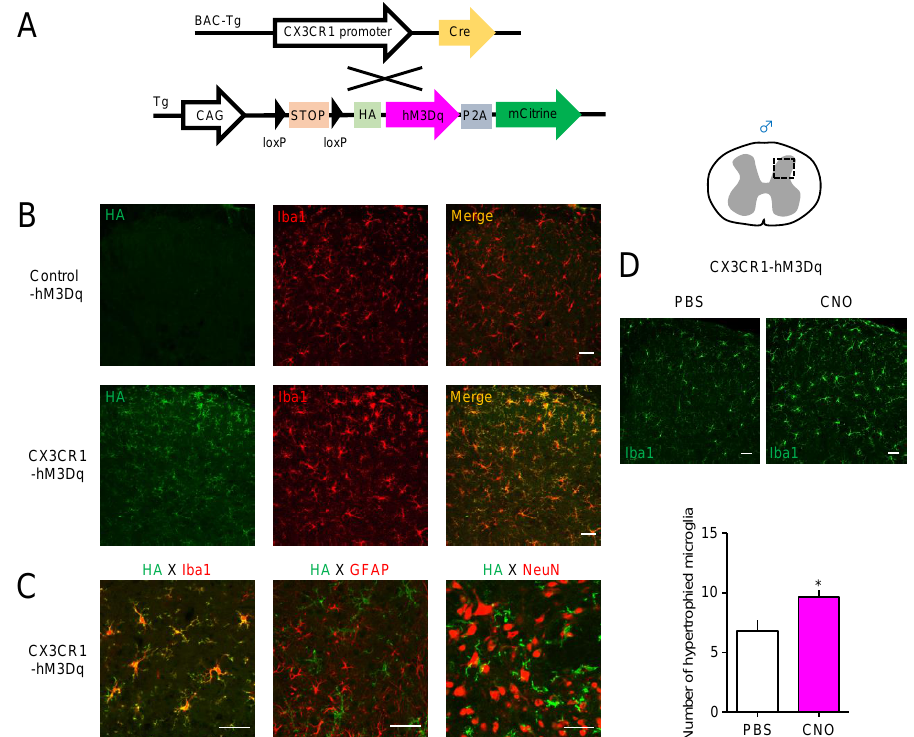
Figure 1. Activation of spinal microglia by clozapine-N-oxide (CNO) in male CX3C chemokine receptor 1, human Gq-coupled M3 muscarinic receptors (CX3CR1-hM3Dq) mice. ( A ) Scheme of Cre- dependent expression of hM3Dq in CX3CR1-expressing (CX3CR1 + ) cells by crossing CX3CR1-Cre (Tg) mice with CAG-LSL-Gq-designer receptors exclusively activated by designer drugs (Gq-DREADD) mice (Control-hM3Dq). (B–D) CNO (2 nmol) was intrathecally (i.t.) administered to male naïve Control-hM3Dq and CX3CR1-hM3Dq mice, and immunohistochemistry was performed one day after administration. ( B ) The Cre-dependent expression of hemagglutinin (HA)-tagged hM3Dq on the spinal dorsal horn (DH) in Control-hM3Dq and CX3CR1-hM3Dq mice. ( C ) Localization of HA-hM3Dq in Iba1 + microglia, but not GFAP + astrocytes or NeuN + neurons. ( D ) Representative micrographs and the number of Iba1 + microglia within the square of 200 × 200 µ m 2 in the spinal DH in male CX3CR1-hM3Dq mice administered phosphate-buffered saline (PBS) or CNO. Data are presented as mean ± standard error of the mean (SEM). n = 4–8. *, p < 0.05. The square in the spinal cord shows the region of micrographs. Scale bars = 40 µ